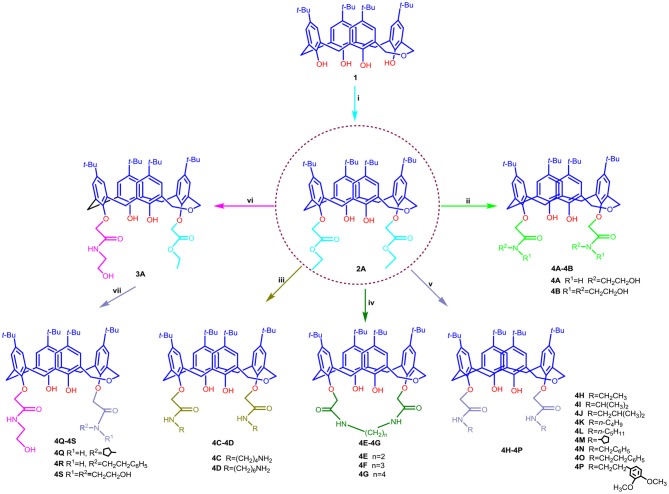
Synthetic routes for dihomooxacalix[4]arene amide derivatives 4A–4S. Reagents and conditions: (i) BrCH2COOC2H5, K2CO3, acetone, reflux; (ii) NH2CH2CH2OH or NH(CH2CH2OH)2, ethanol/toluene, reflux; (iii) NH2(CH2)nNH2 (n = 4, 6), methanol, rt; (iv) NH2(CH2)nNH2(n = 2, 3, 4), ethanol, reflux; (v) NH2R, ethanol; (vi) NH2CH2CH2OH, dichloromethane; (vii) NH2R, rt.